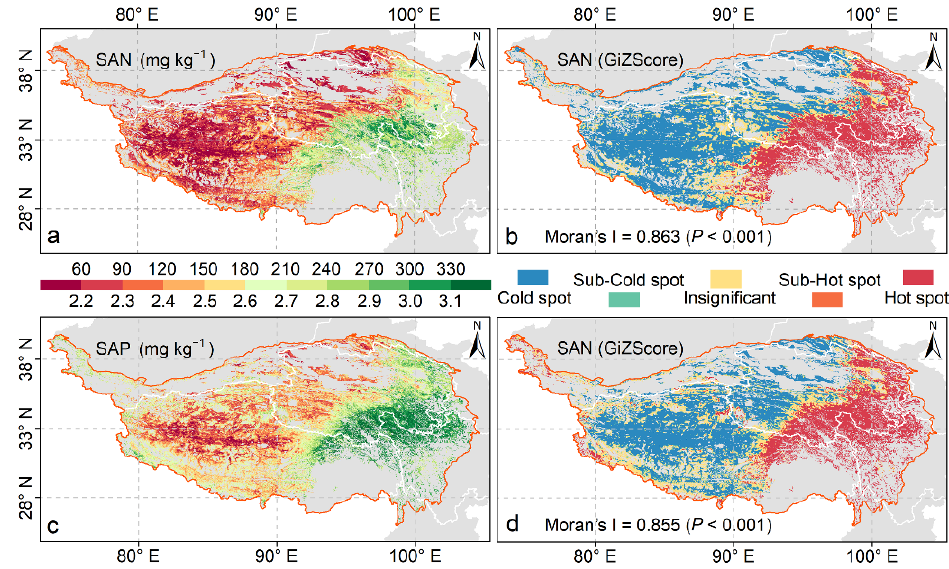
Figure 4. Spatial pattern and spatial autocorrelation of SAN and SAP: ( a , c ) denote the spatial distribution of SAN and SAP, respectively; ( b , d ) denote the spatial autocorrelation results of SAN and SAP, respectively. Moran’s I stands for Global Moran’s Index; GiZScore stands for Getis-ord Gi* Index, which is divided into five classes: cold spot, sub-cold spot, insignificant, sub-hot spot, hot spot. The means of SAN and SAP in 2015 for QZP alpine grasslands were 139.96 mg kg −